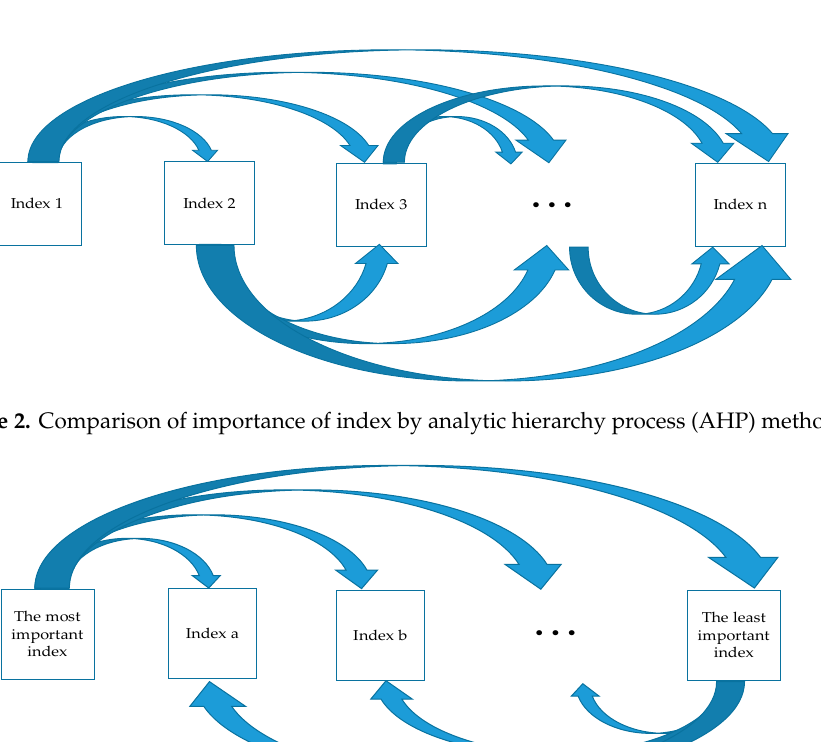
Figure 3. Comparison importance of index by best–worst (BW) method.